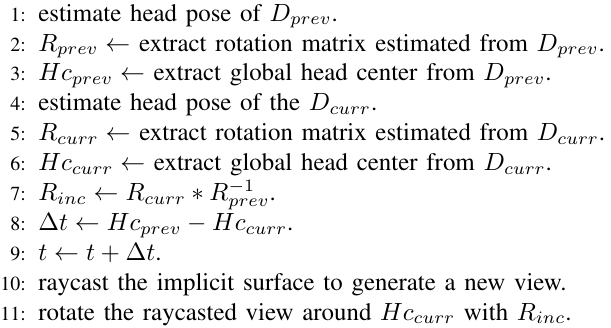
Algorithm 1 Use of the head pose